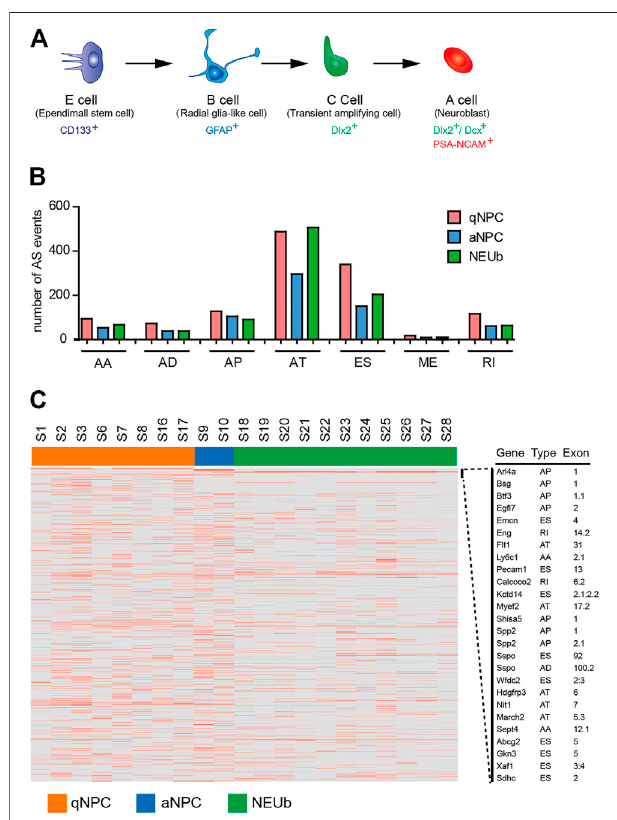
FIGURE3| Detectionofhighlyheterogeneticsplicevariantsinstemcells of the SVZ. (A) Schematic diagram of major cell types in the adult mouse subventricular/subependymal zone (SVZ/SEZ). CD133 + E cells represent some quiescent stem cells; GFAP + B cells are also regarded as SEZ- activated neural stem cells (NSCs); C cells are the transitional cells from B to A cells,andA cellsareneuroblasts. (B) ComparisonofnumberandtypeofAS events among quiescent neural stem cells, activated neural stem cells, and neuroblastcells. (C) Heatmapofcell-type-speci fi canddifferentiallyexpressed alternative splicing events. The horizontal axis shows the clustering information of samples divided into three major clusters: quiescent neural stemcells(8samples),activatedneuralstemcells(2samples),andneuroblast cells (11 samples).